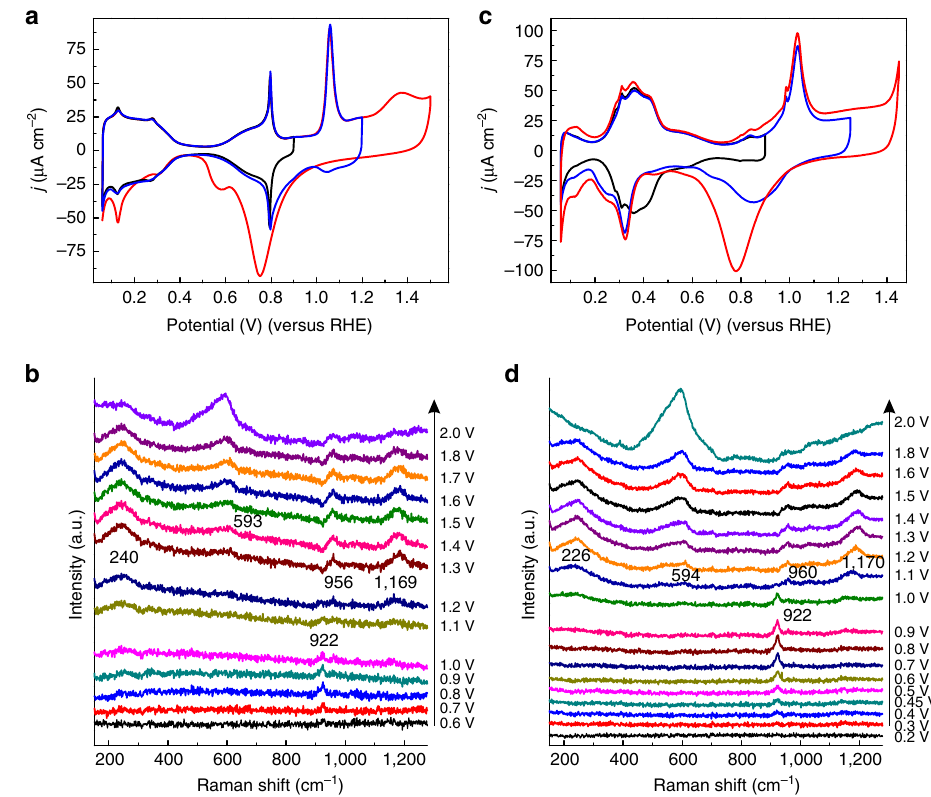
Figure 1 | Cyclic voltammograms and potential dependent Raman spectra of Pt(111) and Pt(100). ( a ) Voltammogram of Pt(111) in 0.1M HClO 4 electrolyte; scan rate 50mVs (cid:2) 1 . ( b ) SHINERS spectra of Pt(111) at the indicated potentials. ( c ) Voltammogram of Pt(100) in 0.1M HClO 4 electrolyte; scan rate 50mVs (cid:2) 1 . ( d ) SHINERS spectra of Pt(100) at the indicated potentials. The SHINERS spectra were recorded with the potential stepped positively; every spectrum was collected in